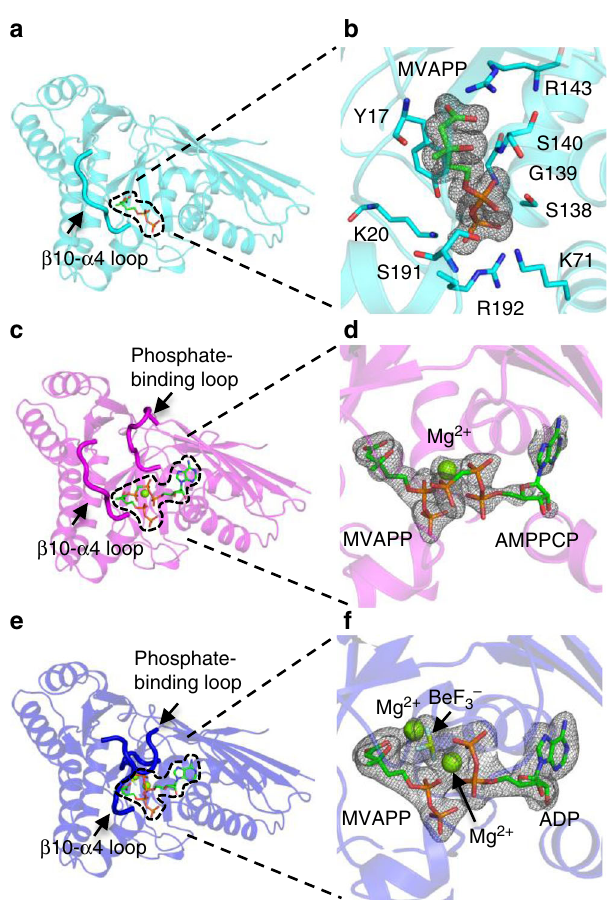
Fig. 2 Structural models of bound forms of MDD EF . a Structural model of MDD EF -MVAPP. The β 10- α 4 loop is indicated by a black arrow. b SA- ligand-omit map of MVAPP of MDD EF -MVAPP. The map is presented at a sigma level of three (3 σ ). MVAPP and the interacting residues in the active site of MDD EF are shown as stick models. c Structural model of MDD EF - MVAPP-AMPPCP-Mg 2 + . The β 10- α 4 loop and the phosphate-binding loop are indicated by black arrows. d SA-omit map (3 σ ) of ligands of MDD EF - MVAPP-AMPPCP-Mg 2 + . e Structural model of the MDD EF -MVAPP- ADPBeF 3 -Mg 2 + . The β 10- α 4 loop and the phosphate-binding loop are indicated by black arrows. f SA-omit map (3 σ ) of ligands in MDD EF - MVAPP-ADPBeF 3 -Mg 2 + . Ligand-binding sites in a , c , and e are indicated by dashed